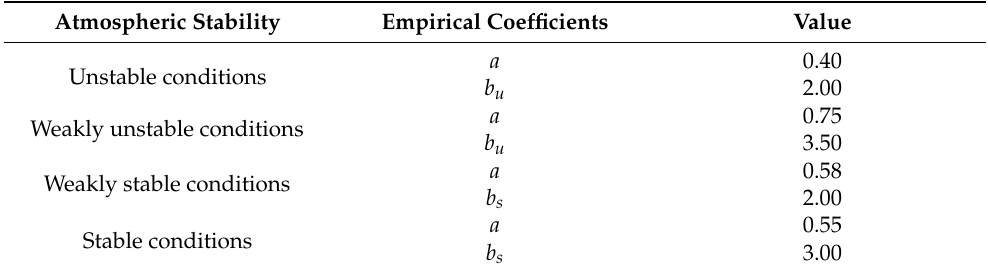
Table 1. Revised empirical coefficients for Equations (1) and (2) under different stability conditions.